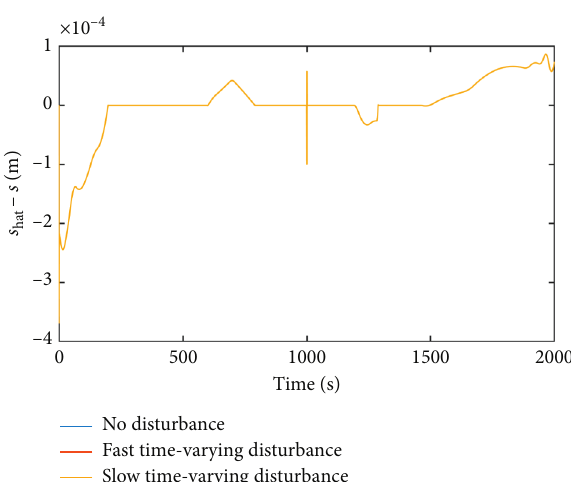
Figure 14: Velocity observer estimation error of the HST.